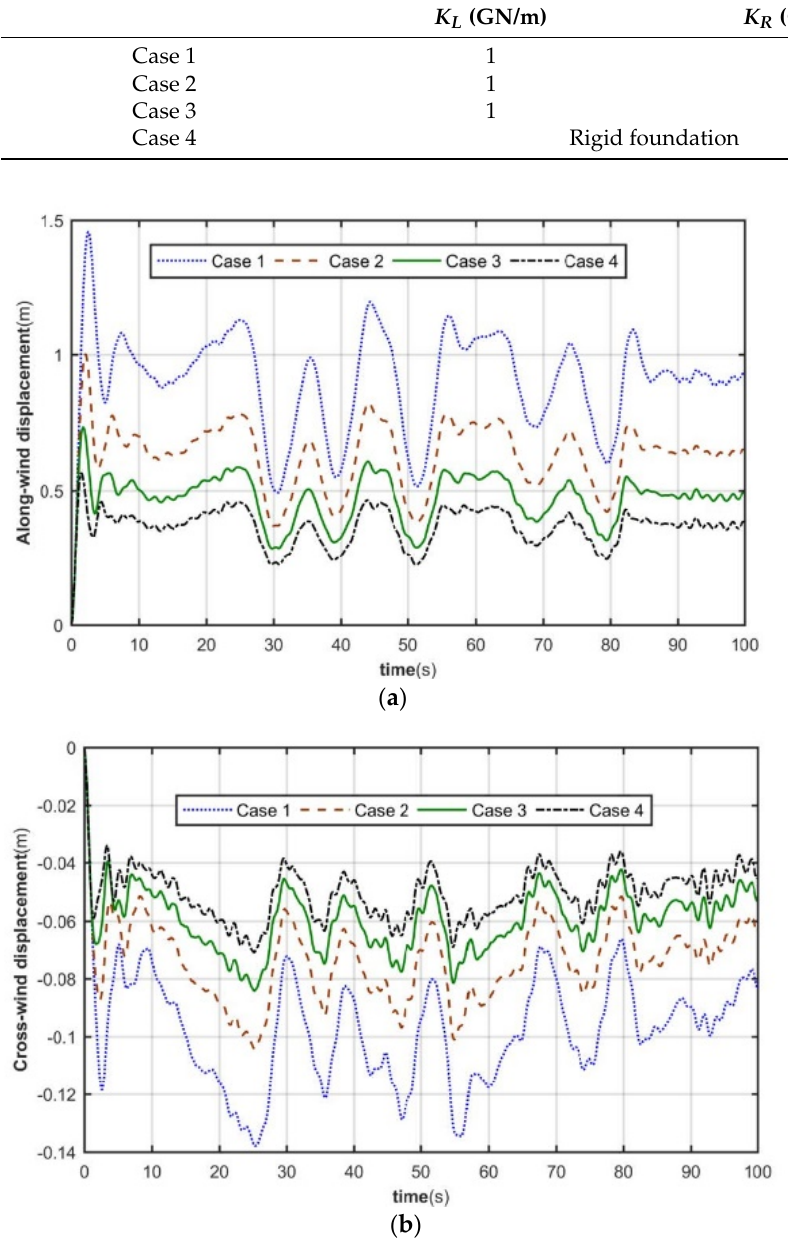
Figure 11. Time course of tower top displacement. ( a ) Downwind. ( b ) Sidewind direction.